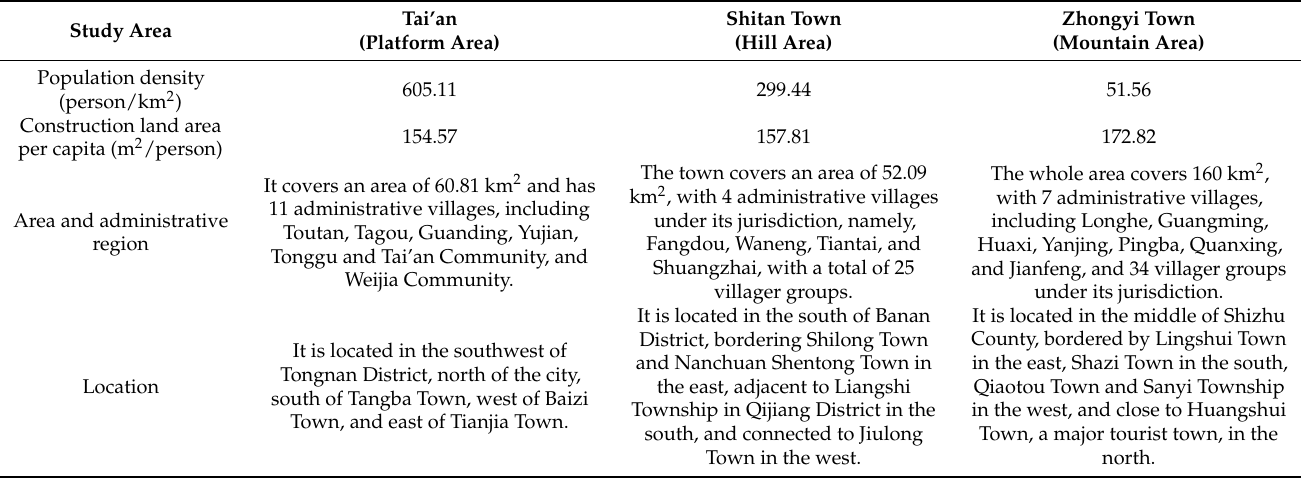
Table 1. Basic information for the selected